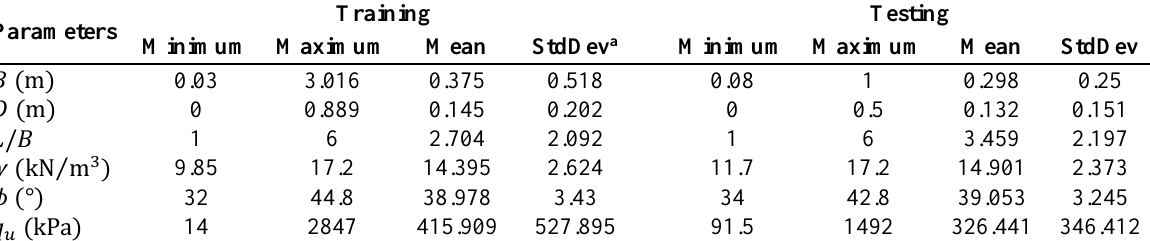
Table 2. Statistics of input factors in